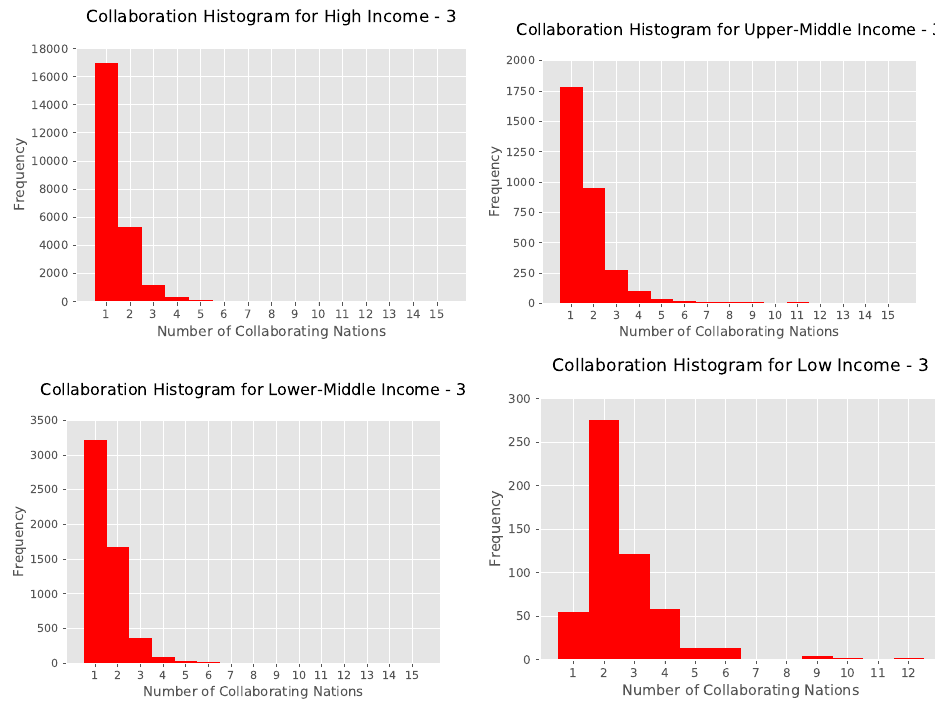
Figure 20. The distribution of distinct nations represented on papers in the medical and health sciences by income group.